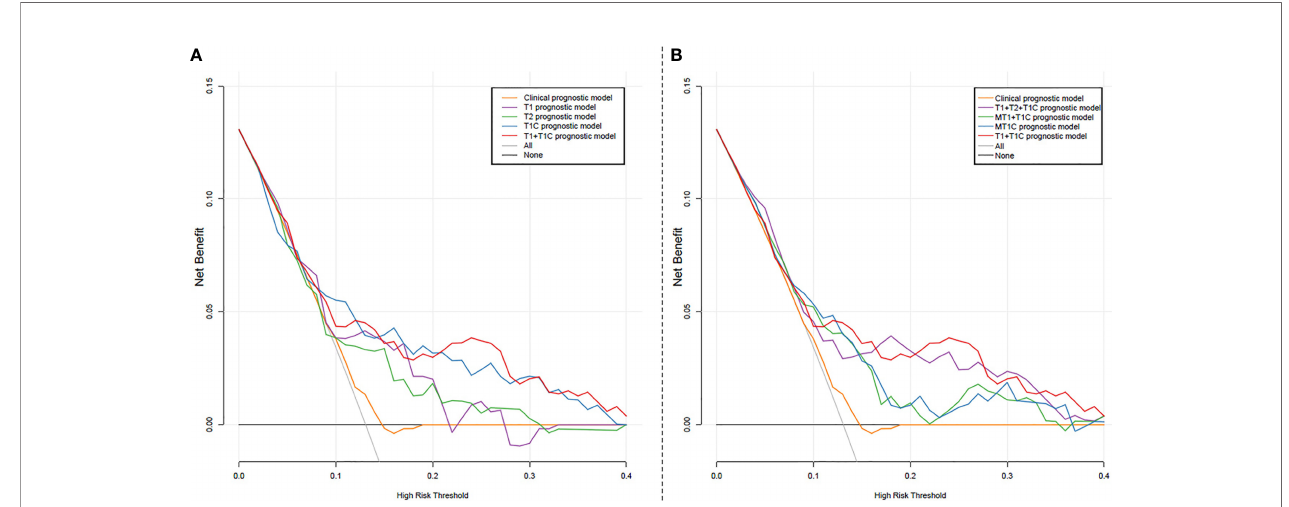
FIGURE 3 | Decision curve analysis for the prognostic models: (A) Clinical prognostic model, and radiomics models T1, T2, T1C, T1+T1C; (B) Clinical prognostic model, radiomics models T1+T2+T1C, T1+T1C, MT1+T1C model, and rMT1C mode. The X-axis represents the probability of the 5-year distant metastasis-free survival ranging from 0 to 100%. The Y-axis shows the net bene fi t. The black line indicates that no distant metastasis occurred in all patients. The gray line represents the assumption that all patients developed distant